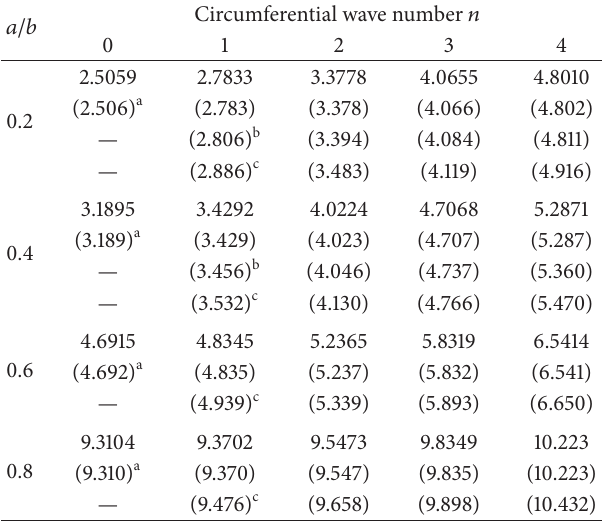
Table 2: Convergence study for frequency parameters Ω = 𝜔𝑏(𝜌(1−